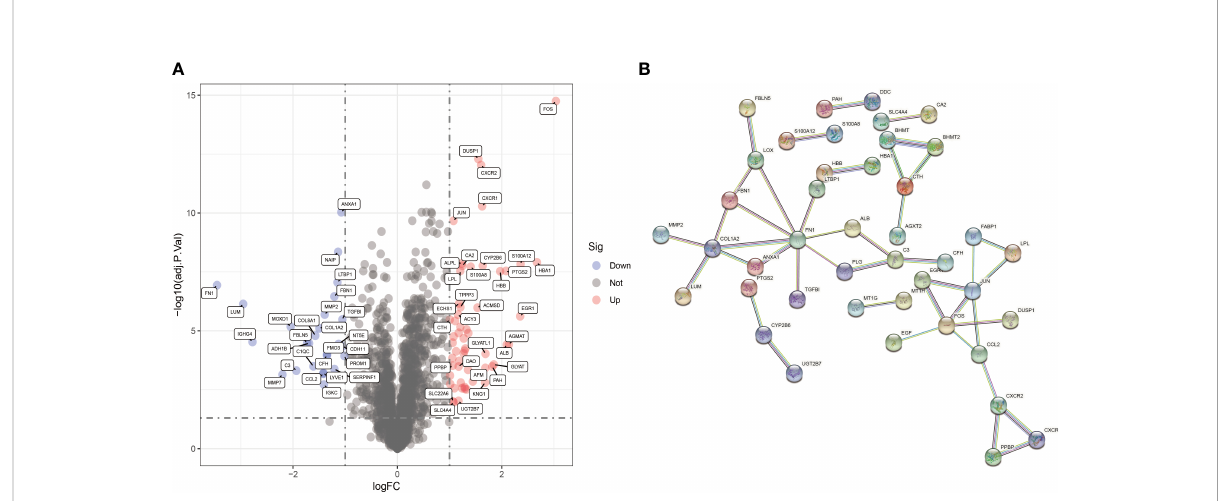
FIGURE 3 Identi fi cation of DECRGs. (A) Volcano plot of DECRGs between normal and DN samples. (B) PPI network for DECRGs in DN (80 nodes and 42